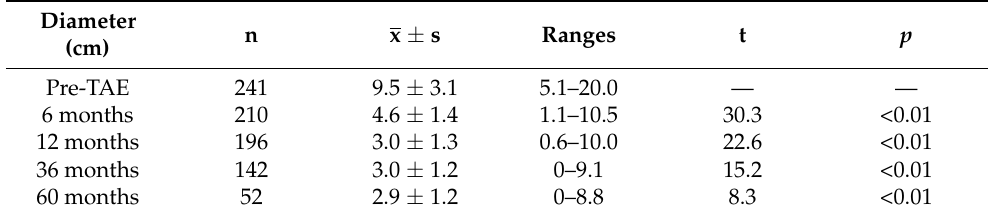
Table 2. Comparison of the maximum diameters of the hepatic hemangiomas post-TAE during the follow-up period.